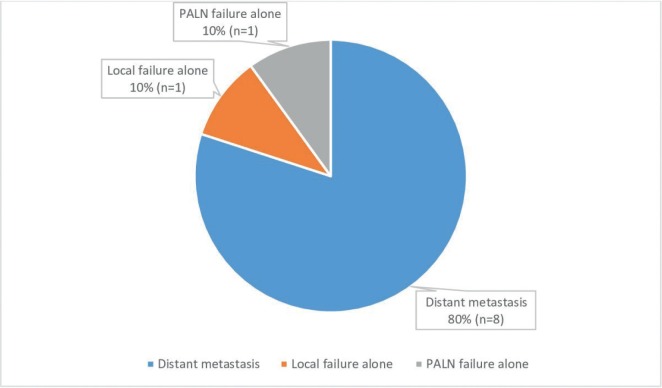
Patterns of failure.